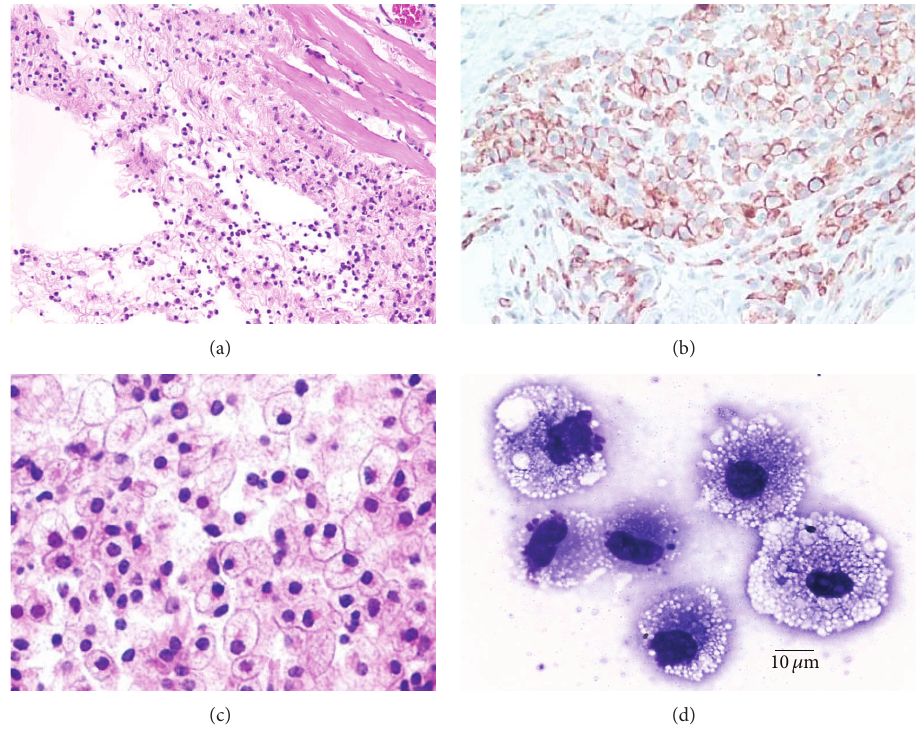
Figure 2: Recruitment of macrophages by 10 mg 𝛼 -gal nanoparticles injected intradermal in anti-Gal producing GT-KO mice. (a) Macrophages migrating toward the injection site, 24 h after injection. The injection site is indicated as the empty area since the 𝛼 -gal nanoparticles are dissolved by the alcohol fixative (H&E × 100). (b) The injection site after 4 days immunostained with macrophage specific HRP-anti-F4/80Ab.TherecruitedcellsarestainedbythisAb( × 200).(c)Theinjectionsiteafter7daysdemonstratingmanylargemacrophages with ample cytoplasm (H&E × 400). (d) Individual macrophages isolated on day 7 displaying large size and multiple cytoplasmic vacuoles, probably the result of activation and uptake of the anti-Gal coated 𝛼 -gal nanoparticles (Wright staining × 1000). Modified from